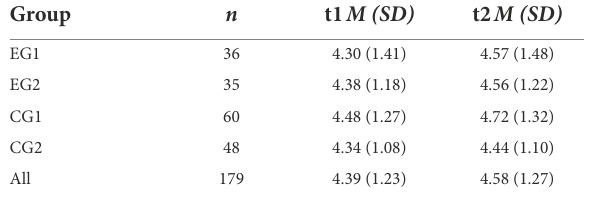
TABLE 5 Perceived utility value of educational sciences pre- and post- differences.